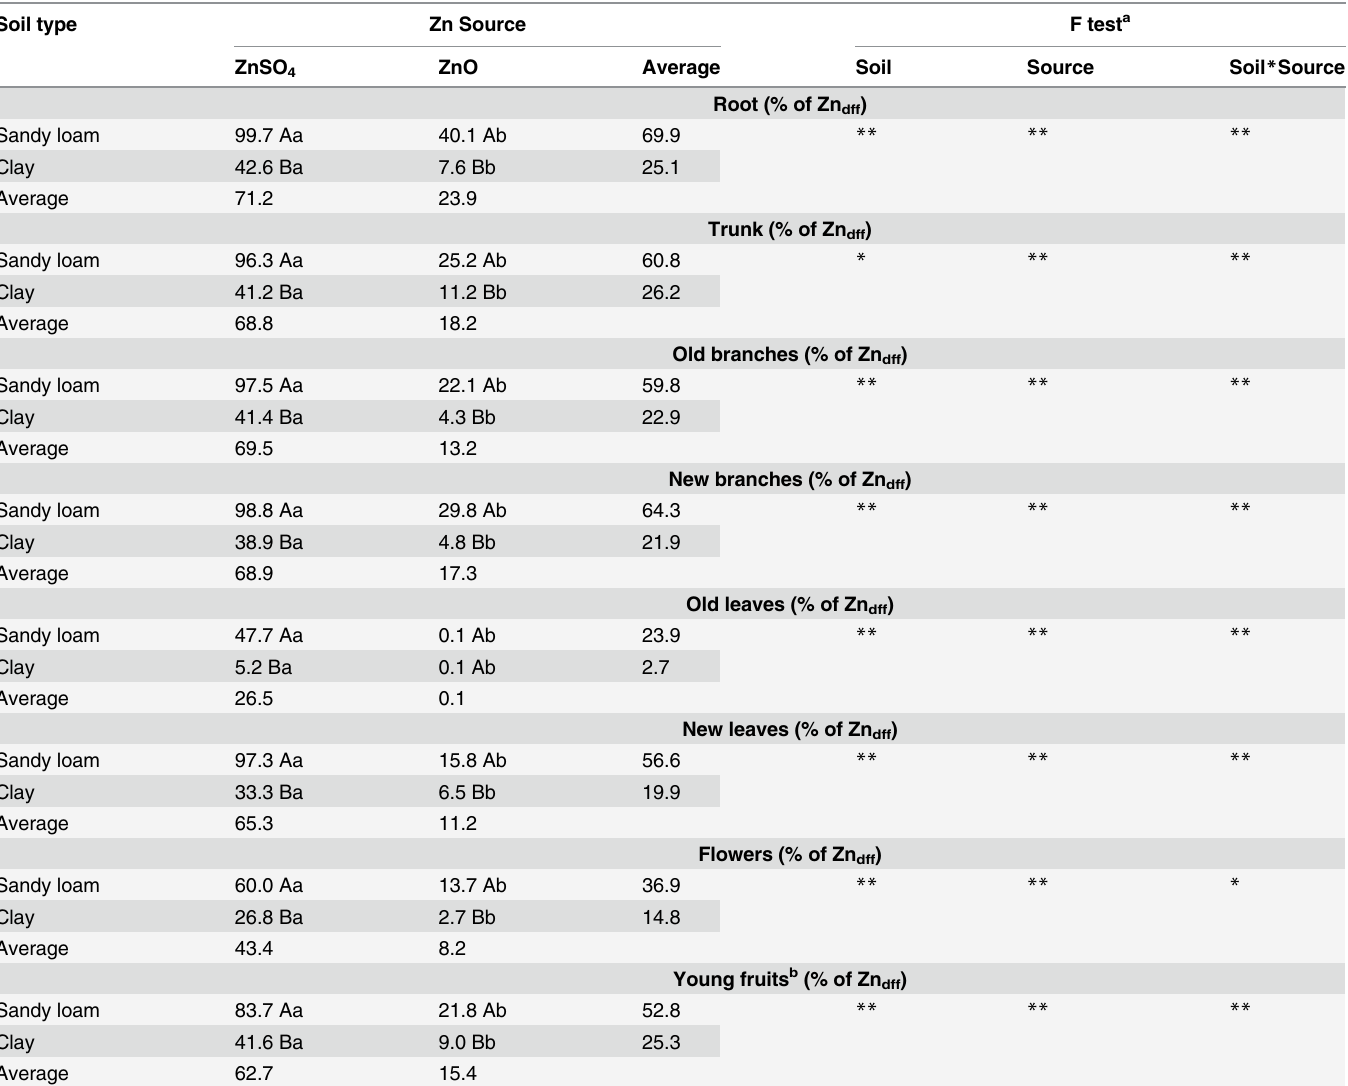
Table 4. Percentage of Zn derived from fertilizer (Zn dff ) in young orange trees 150 days after the application of a Zn-labeled fertilizer (99.0 atom % excess 68 Zn) in soils with a sandy loam or clay texture. Soil